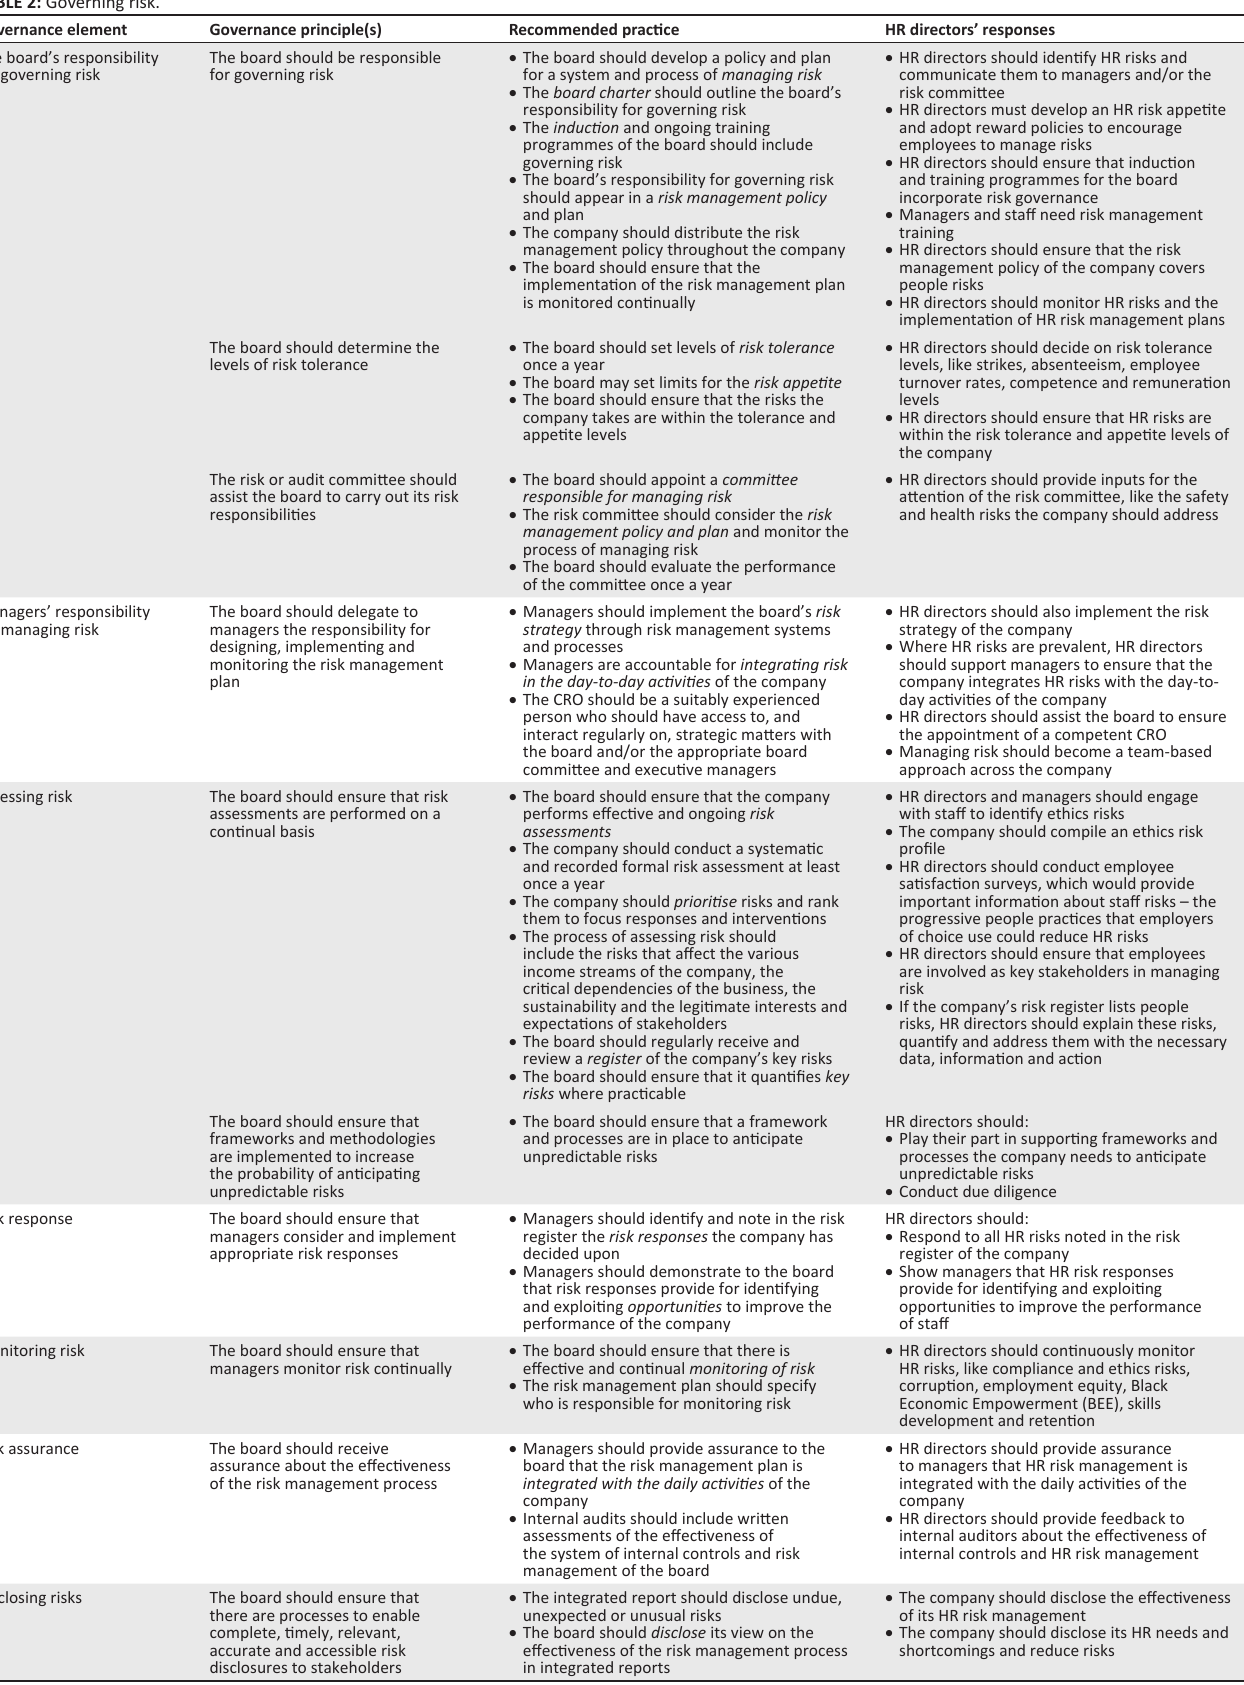
TABLE 2: Governing